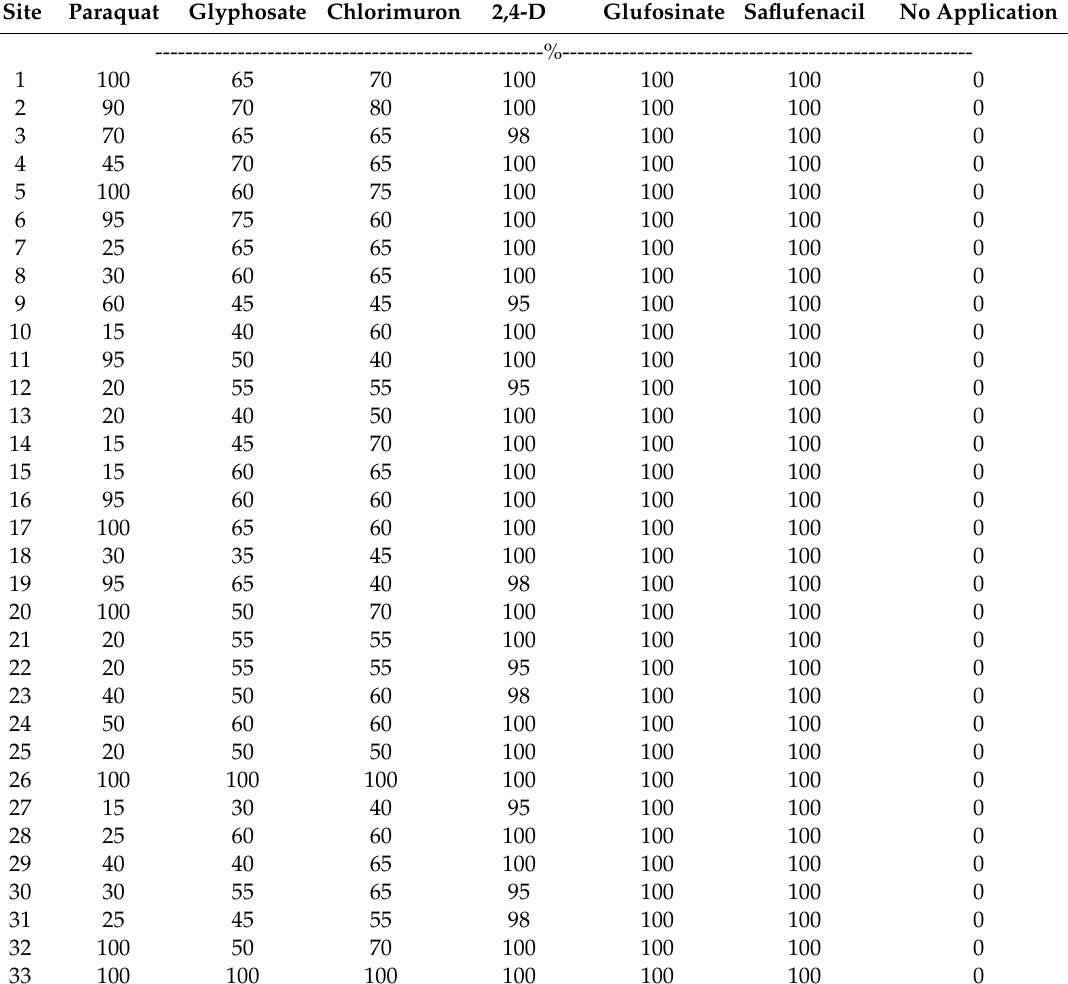
Table 3. Control of the C. sumatrensis populations at 28 days after herbicide application.